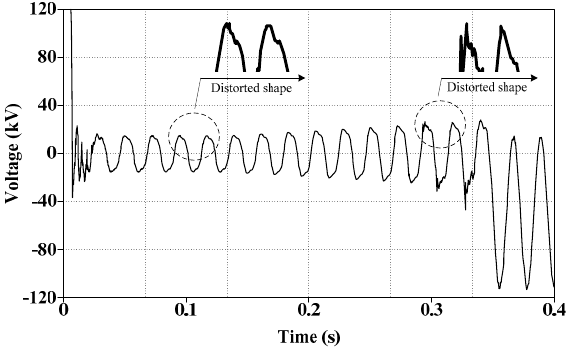
Figure 2. Typical waveform of the secondary arc voltage.